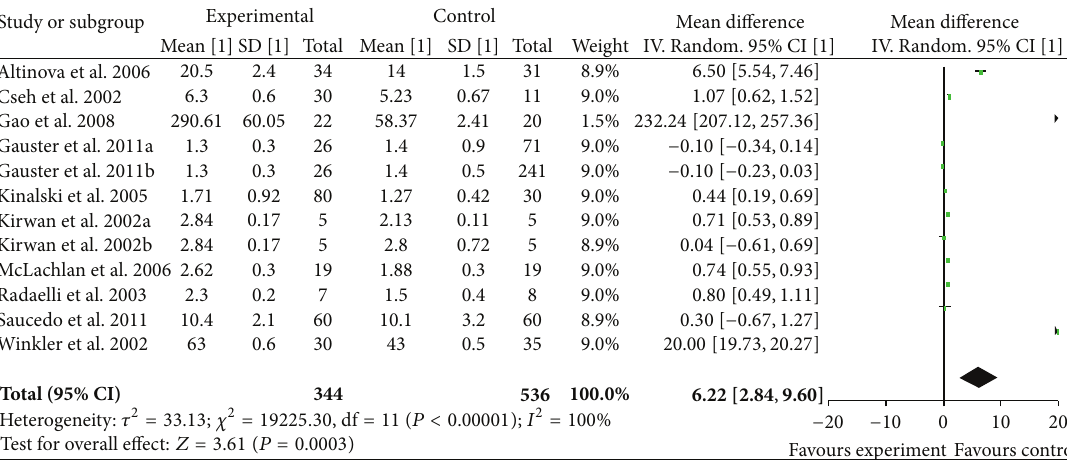
Figure 2: Mean difference (MD) and 95% CI of individual studies and pooled data for the association of maternal concentration of TNF- 𝛼 with GDM risk. Positive values denote higher in GDM patients; negative values denote higher in healthy control subjects.